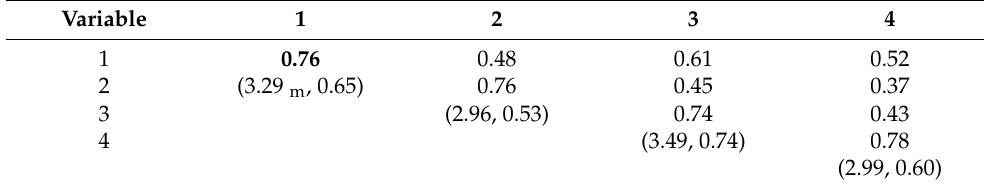
Table 6. Correlations and discriminant validity.